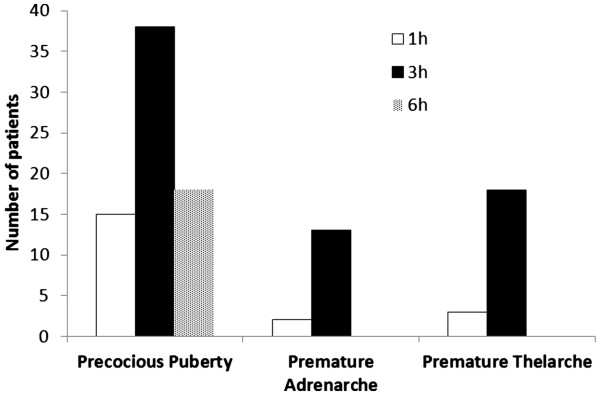
Distribution of number of patients with LH concentration peaked at 1, 3 and 6 hours after leuprolide injection.